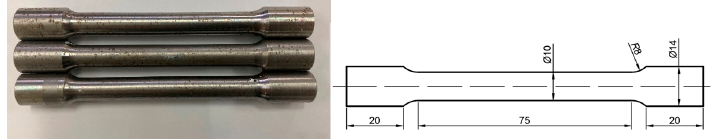
Figure 2. Standard tensile specimen (dimensions in mm).